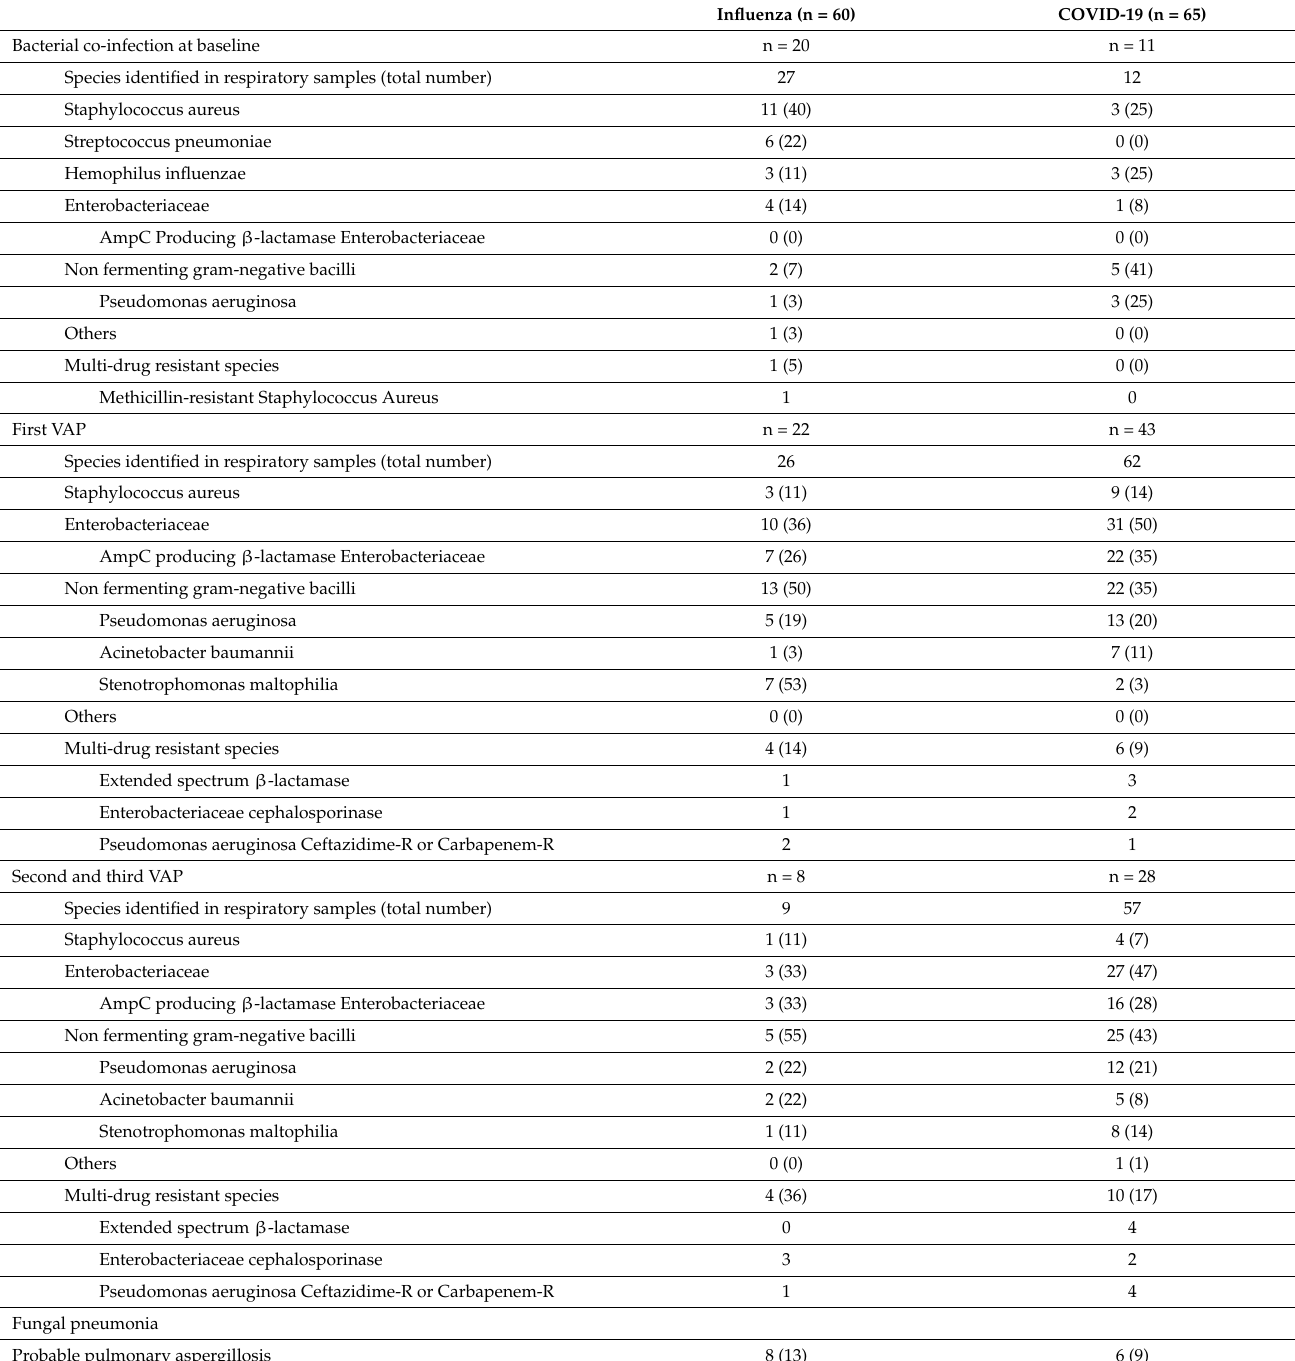
Table 3. Microbiological